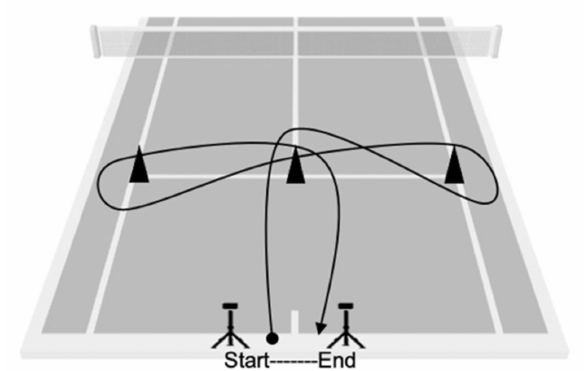
Figure 2. Agility test